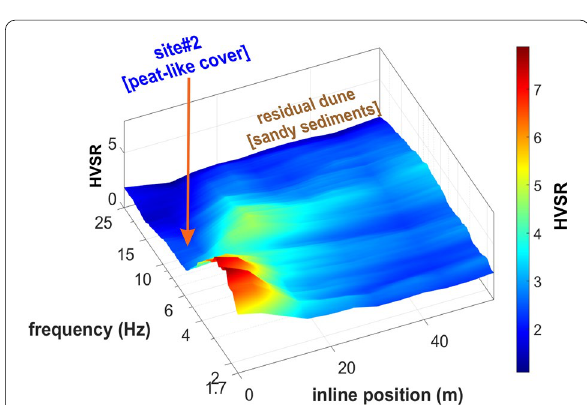
Fig. 16 Beligna#1: 3-component passive seismic array along the same line of the ERT section shown in Fig. 10 (the seismic line is a bit shorter). In general terms, the overall consistency of the 2D HVSR section with the ERT data is obvious. At the beginning of the line (western part), a thick soft-sediment cover creates a large HVSR peak around 2.5 Hz which is related to the low resistivity values obtained from the ERT (Fig. 10). See also the HS analysis in Fig. 15 and the single-component amplitude spectra in Fig.